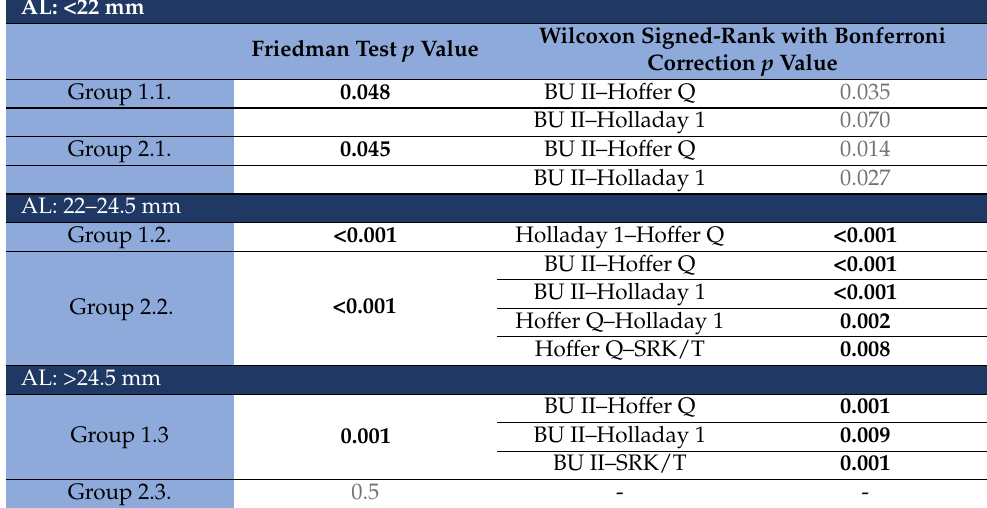
Table 5. p values obtained by the statistical analysis comparing the unoptimized formulas in each group.